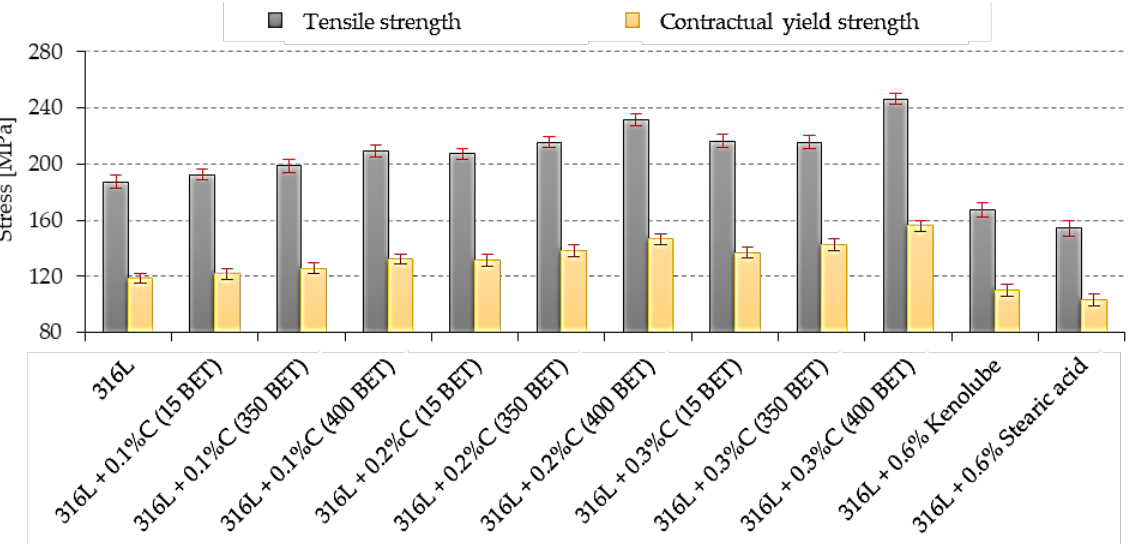
Figure 7. The tensile strength and contractual yield strength of sinters depends on the percentage composition of mixtures.